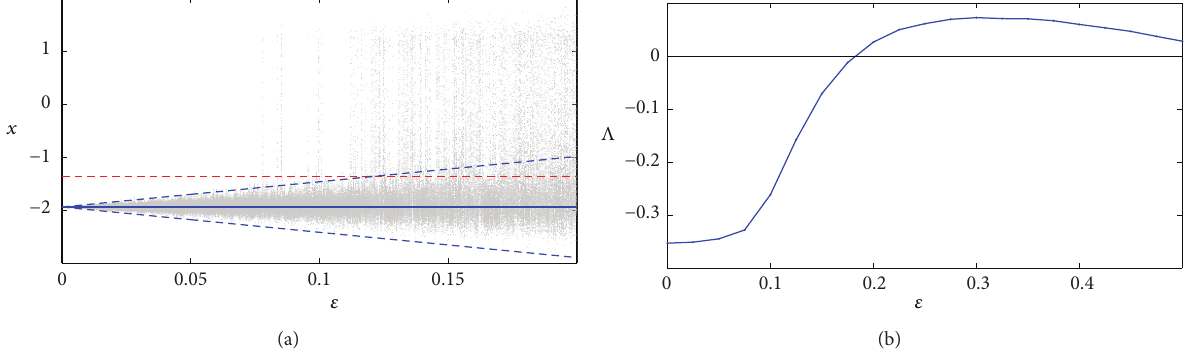
Figure 7: Noise-induced bursting (a) and noise-induced chaotization (b) for 𝛾 = −2.8